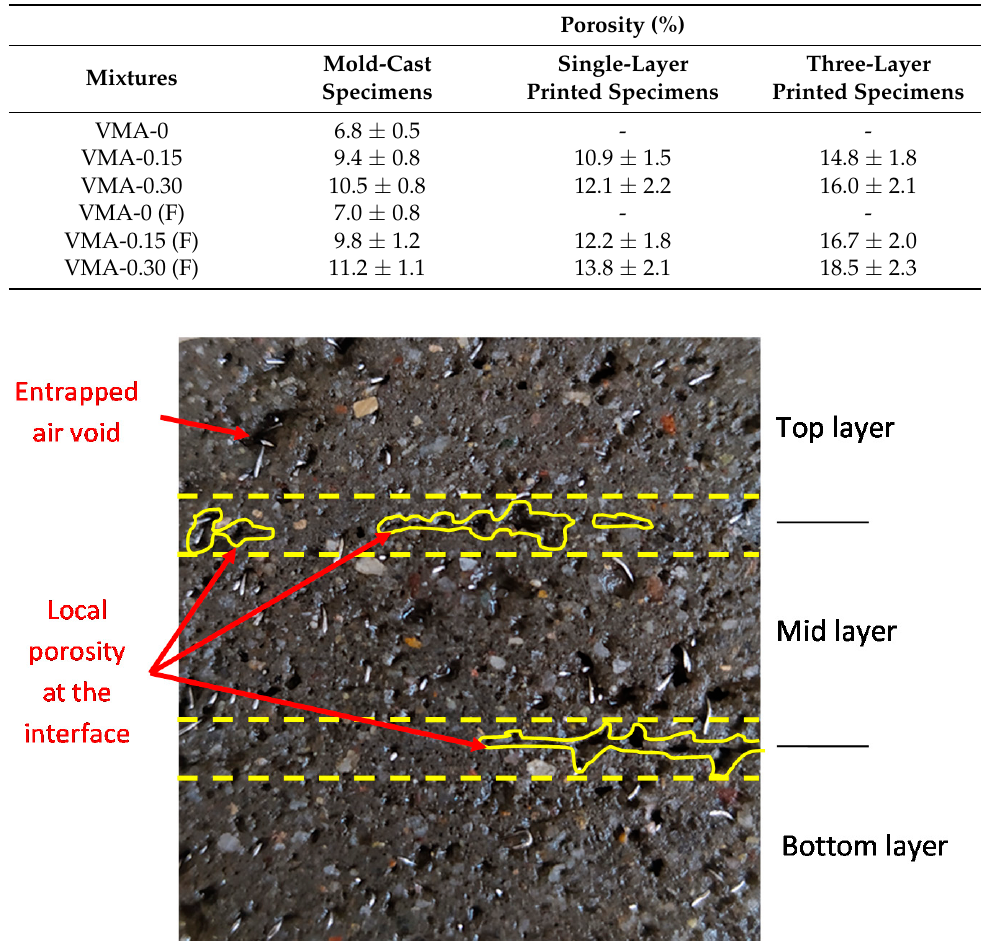
Figure 10. Typical porosity observed at the cross-section of printed specimens (VMA-30 (F)).